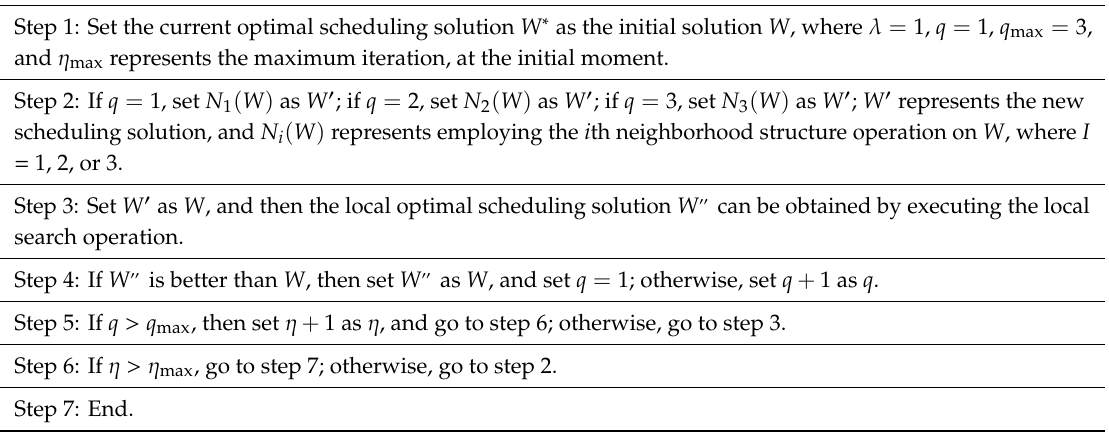
Algorithm 1. The procedure of VNS.